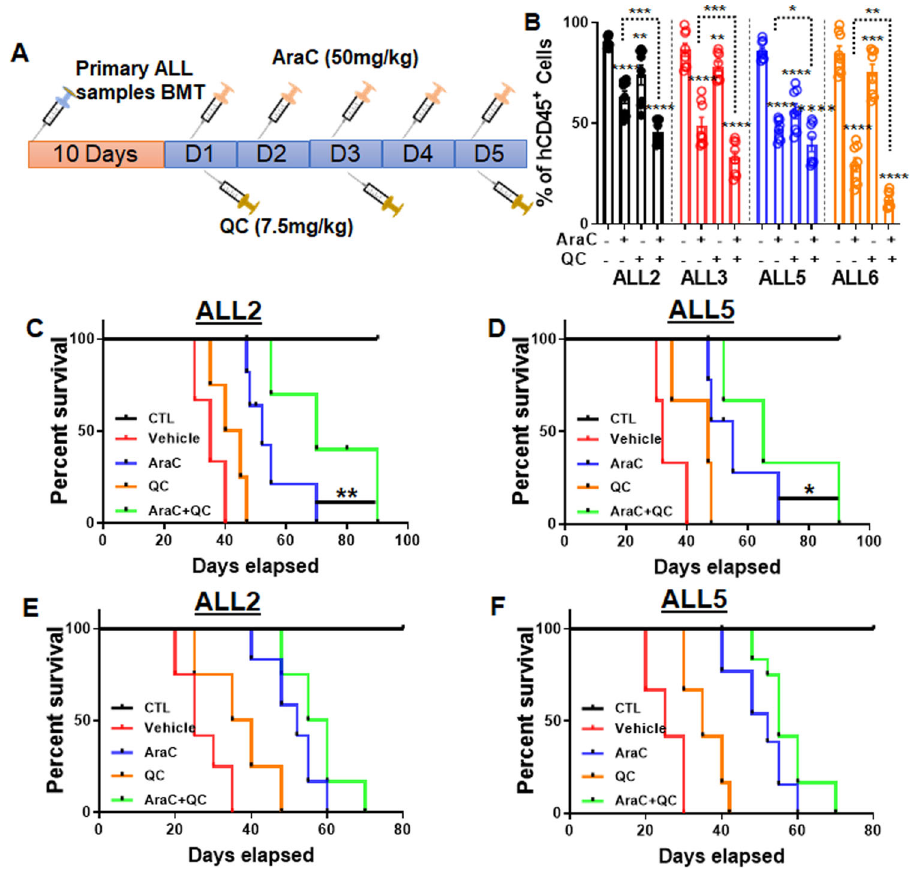
Fig. 4 QC enhances the cytotoxicity of AraC in primary ALL cells but fails to prolong the survival of secondary recipients. A Schematic presentation of experimental design. B QC reduces leukemia burden in primary recipients. Percentage of human cells in the bone marrow of mice transplanted with four ALL patient samples were determined by fl ow cytometry 1-month post-transplant (ALL2: V, n = 10; n = 8 for all other groups). C , D QC prolongs the survival of primary recipients. Survival of recipients transplanted with ALL2 ( C ) or ALL5 ( D ) cells were monitored and plotted by the Kaplan – Meier